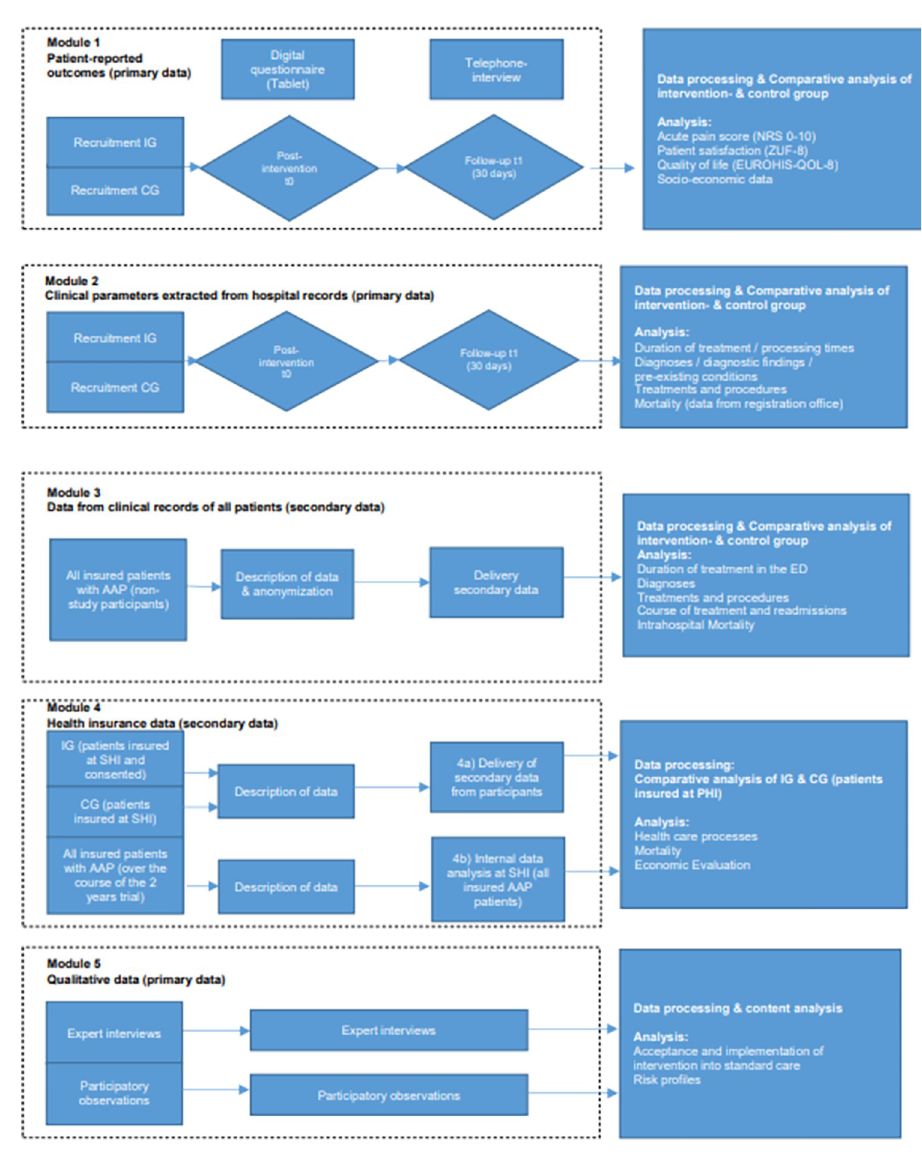
Fig 4. Evaluation